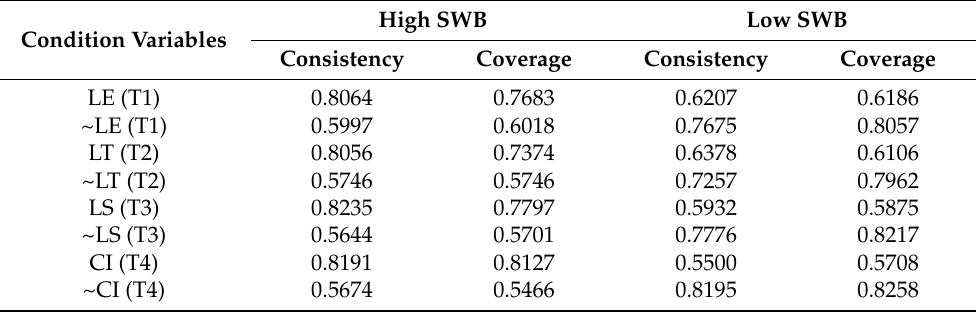
Table 9. The results of the necessity